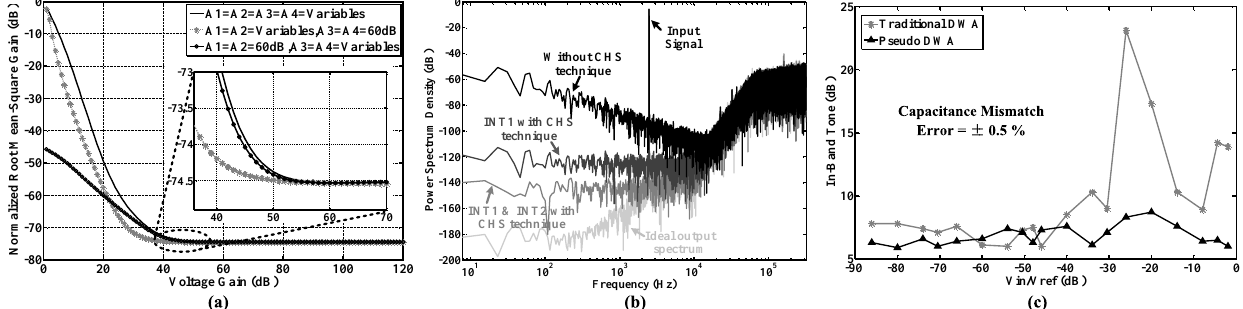
Figure 7. Simulation results of the proposed Delta-Sigma modulator. ( a ) The normalized RMS gain of the proposed noise transfer function ( NTF ) versus different voltage